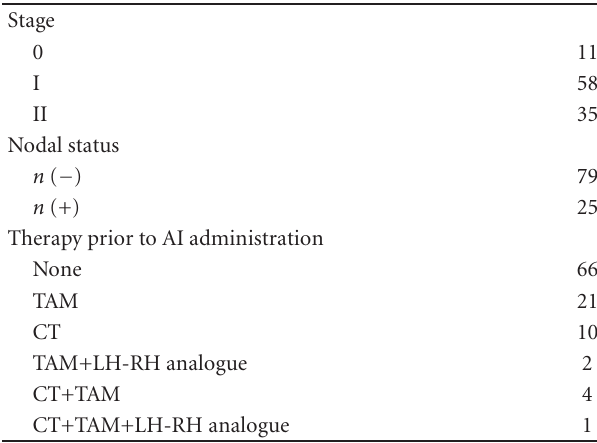
Table 1: The Clinicopathological characteristics ( n =